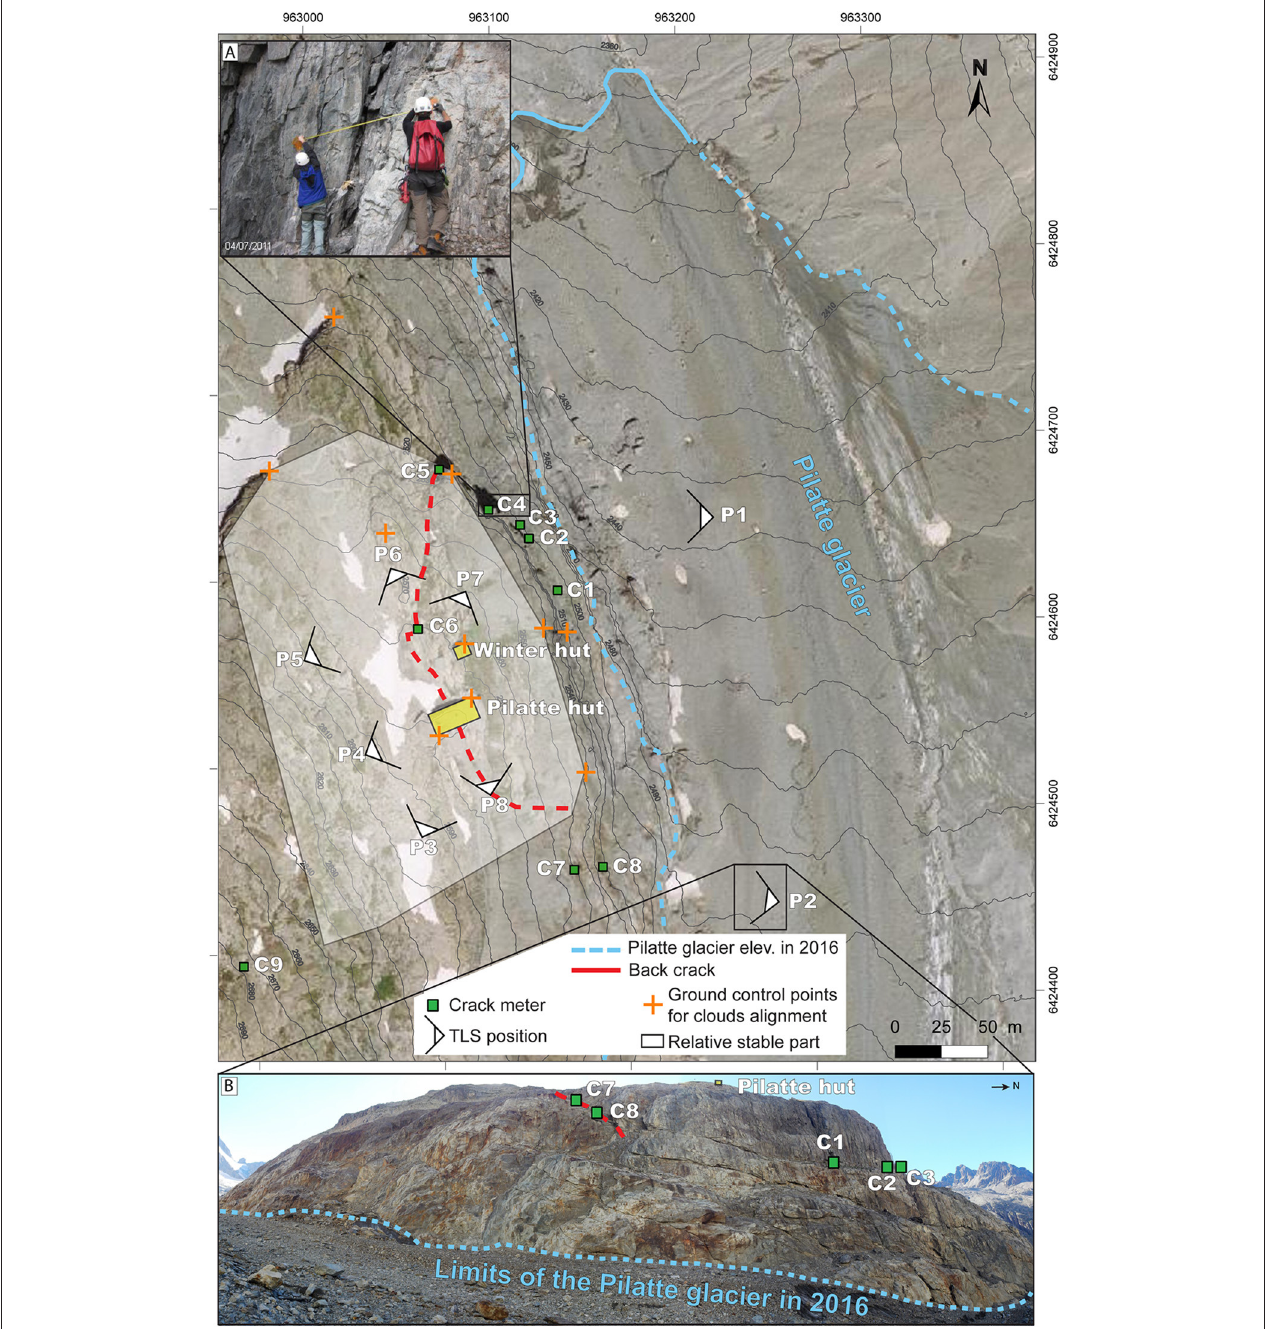
FIGURE 3 | Crack-meter location and TLS survey positions around the Pilatte hut. (A) Crack surveying at C4. (B) The rock slope below the Pilatte hut from P2 (July 2016).